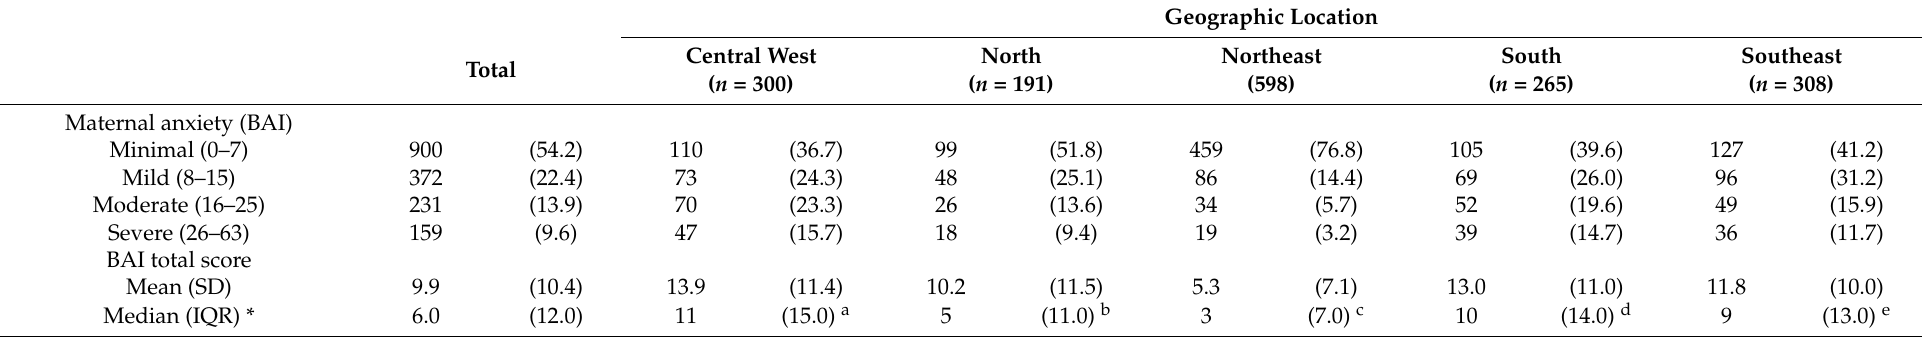
Table 2. Maternal anxiety at end of pregnancy according to geographic regions during the COVID-19 outbreak in Brazil (June–August, 2020).